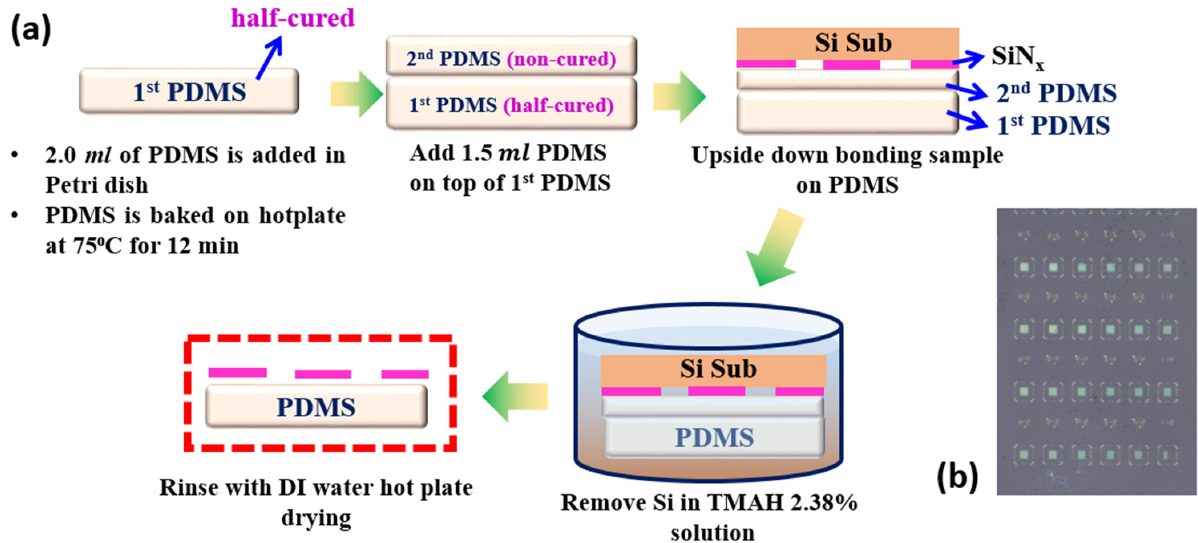
Figure 2. ( a ) Process flow chart of bonding the SiN x pattern on PDMS. ( b ) Optical image of the fab- ricated structure on the PDMS